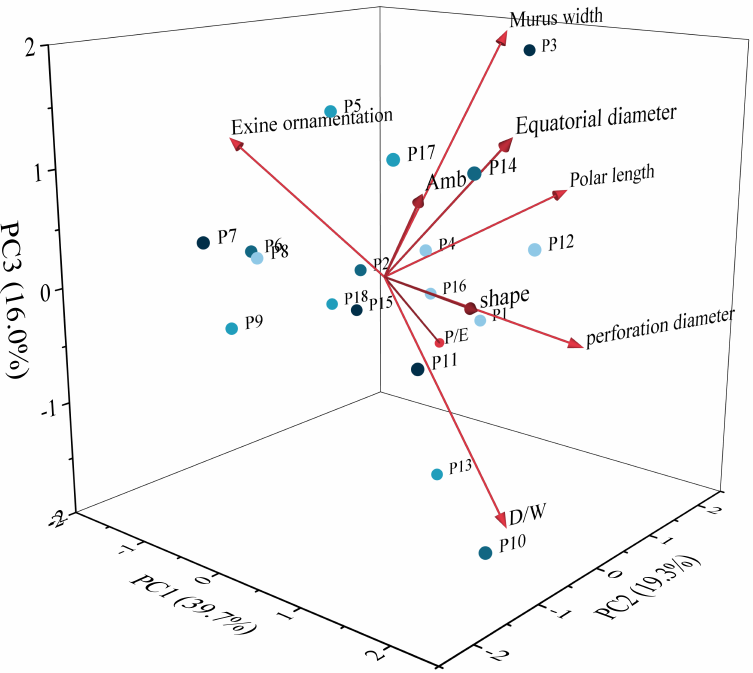
Figure 3. 3D − plot of the principal component analysis (PCA) for pollen characteristics of 18 populations.